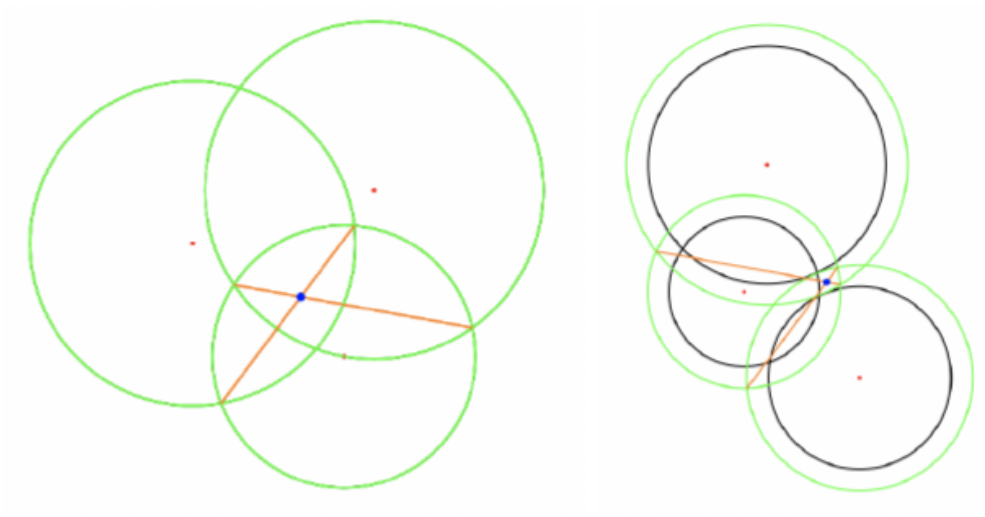
Figure 6. Overview: Beacon type